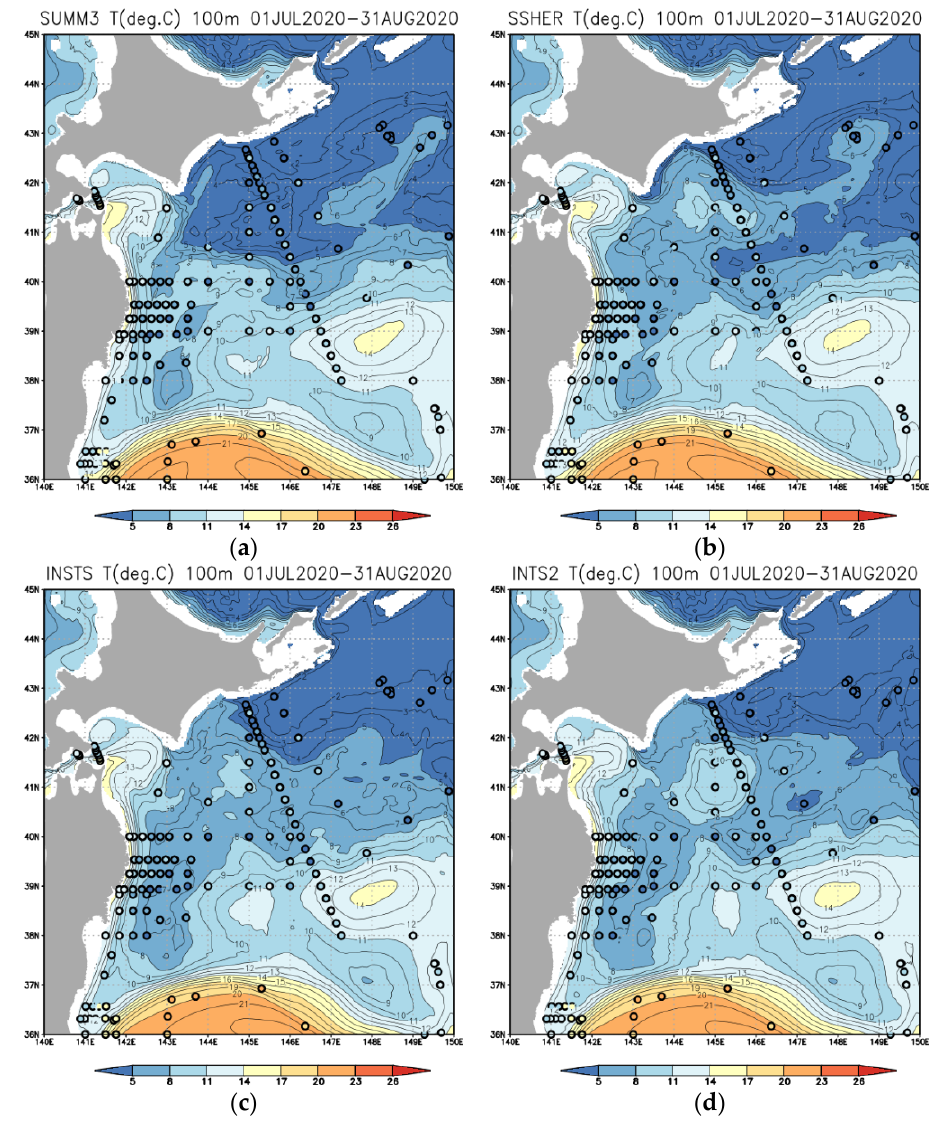
Figure 14. Mean temperature (in °C) of four cases at 100 m depth for the period from 1 July to 31 August 2020. ( a ) SUMM3, ( b ) SSHER, ( c ) INSTS, ( d ) INTS2. Open circles denote the locations of temperature observed during the same period, with the color shade denoting temperature of the in situ data.